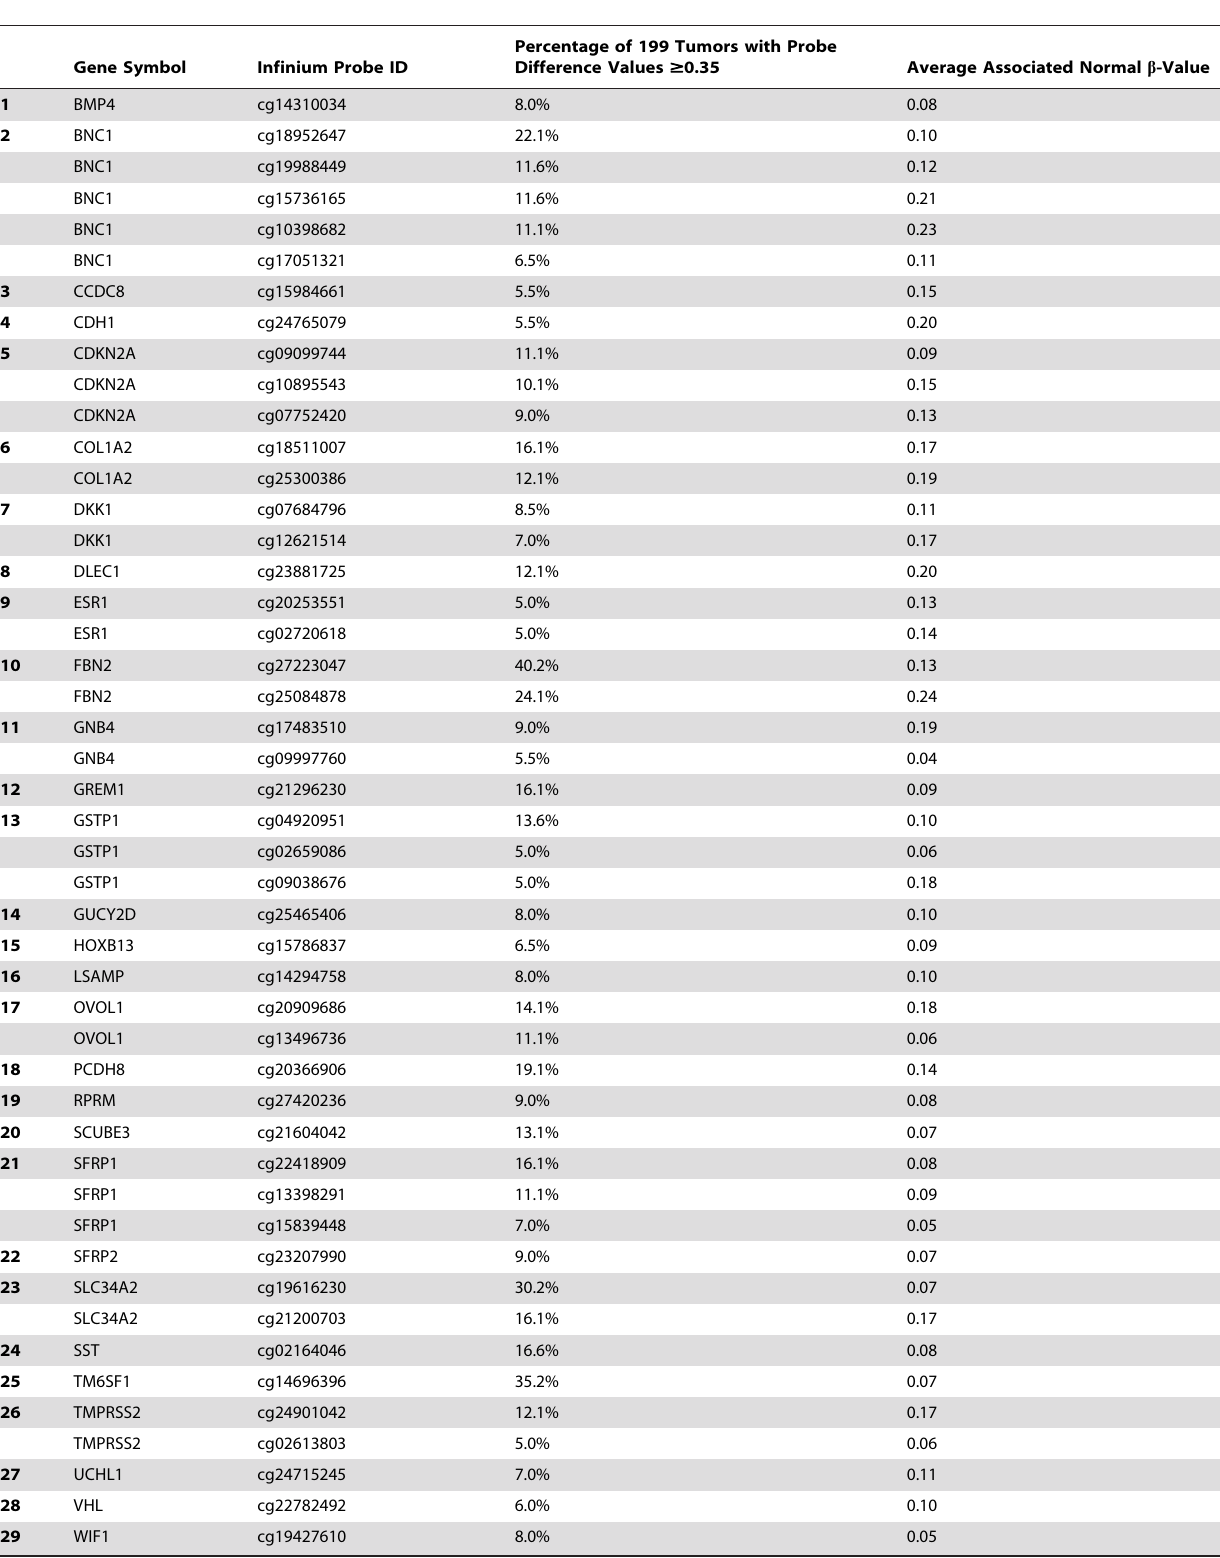
Table 1. Analysis of the Tumor-Specific Probe Hypermethylation in the Candidate Genes for the 199 TCGA RCC Tumor/Normal Pairs Present in the HumanMethylation27 BeadChip